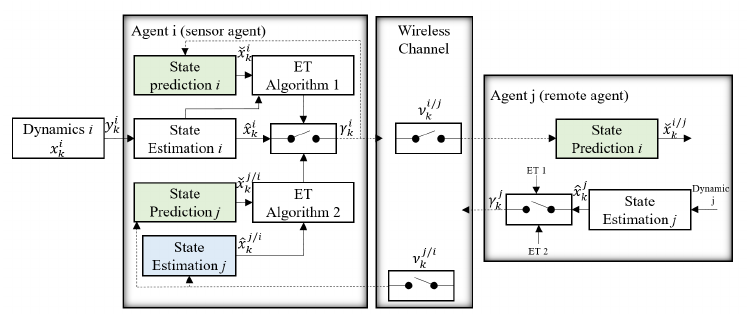
Figure 3. Event triggering problem. The sensor agent i broadcasts its local state estimate ˆ x i a positive triggering decision ( λ i